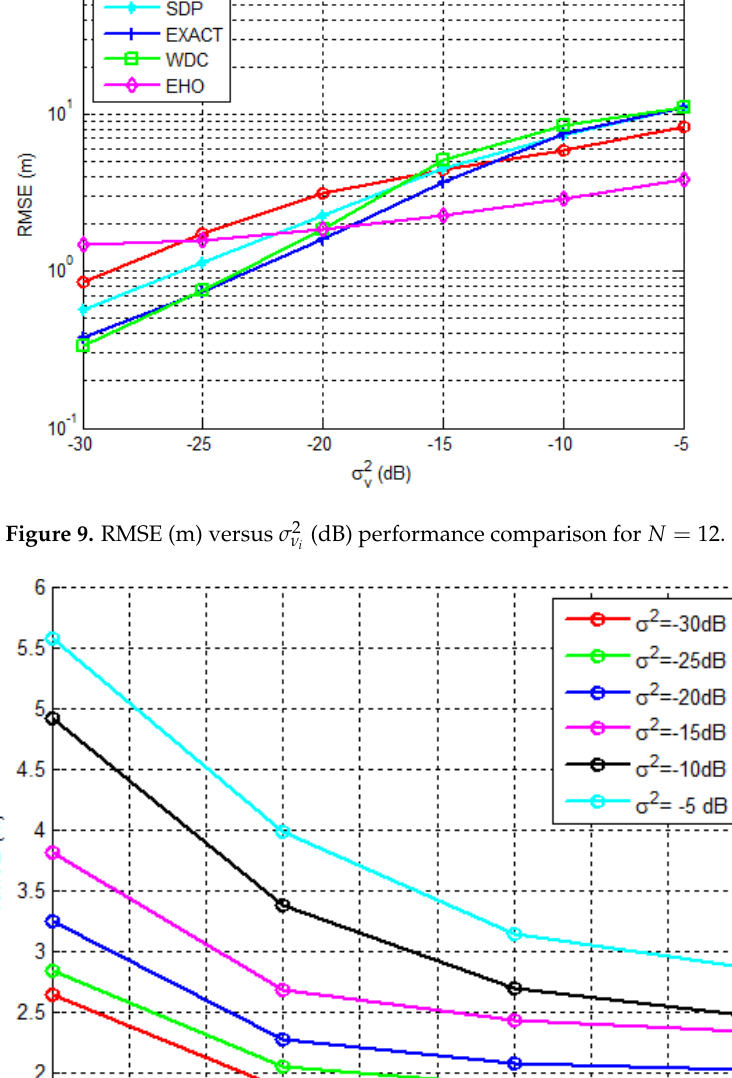
Figure 10. RMSE (m) versus N performance comparison for different σ 2 v